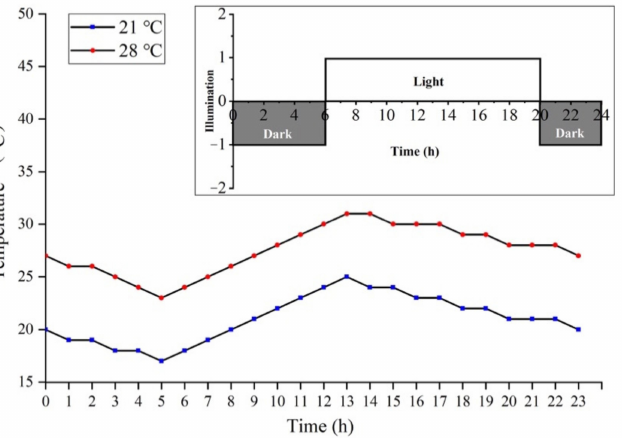
Figure 12. Temperature setting conditions for the low- and high-temperature treatment of PA64S. The red line represents the high-temperature treatment, and the blue line represents the low-temperature treatment. In the light intensity diagram, dark rectangles represent darkness, and light rectangles represent